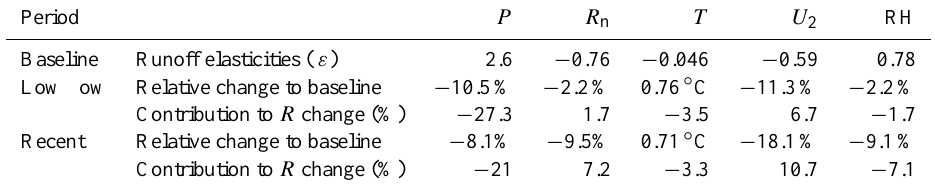
Table 4. Estimated runoff elasticities, climatic variable changes in the low-flow (1991–2002) and recent (2003–2011) periods to the baseline period (1960–1990), and contributions of climatic variable changes to runoff ( R )